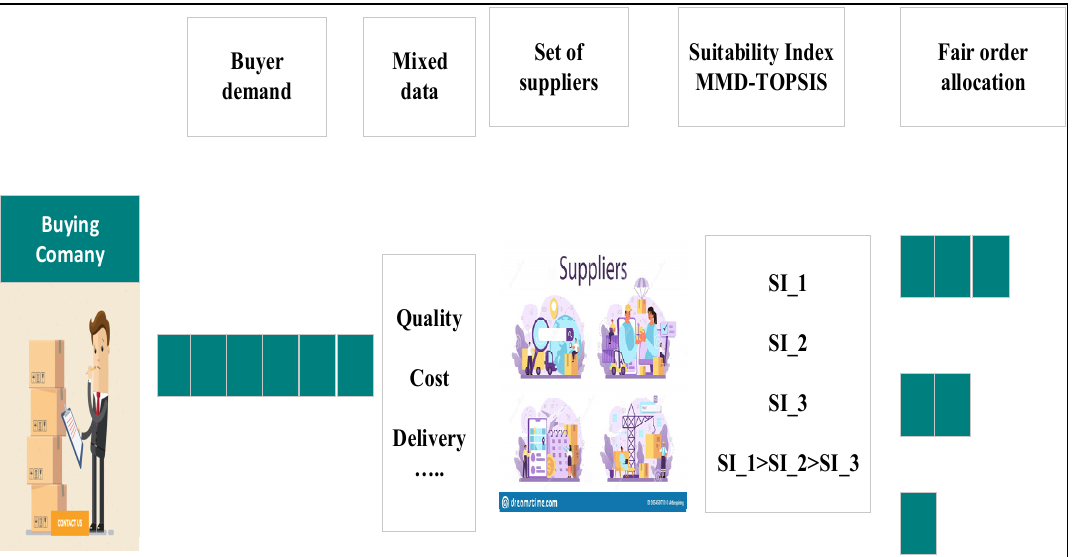
Figure 1. Supplier selection and fair order allocation problem.